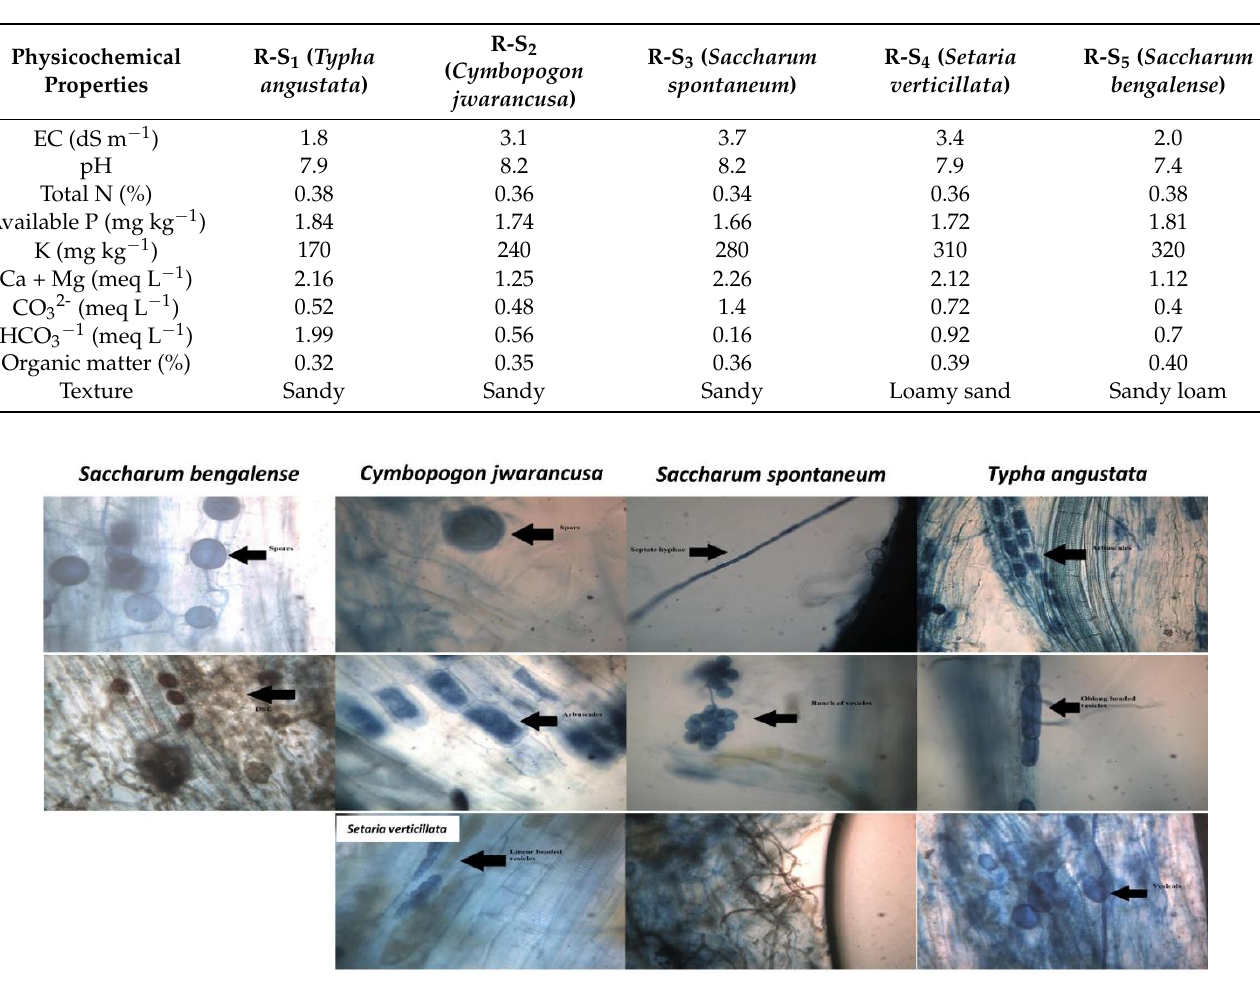
Table 1. Physicochemical properties of collected rhizospheric soil samples.